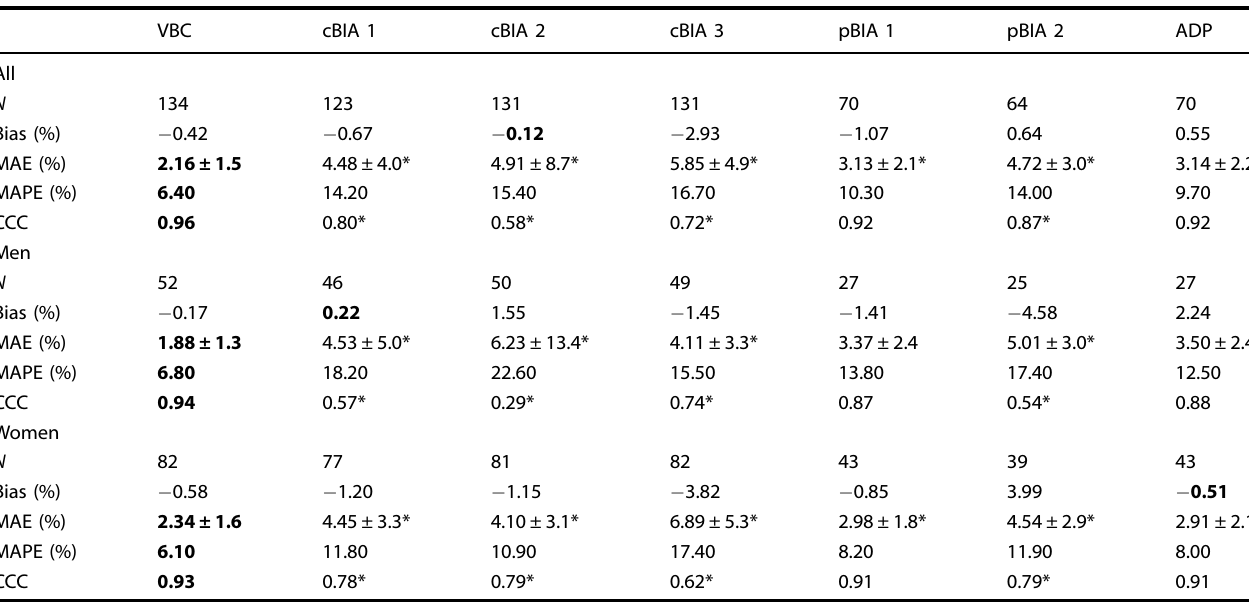
Table 2. Comparison of %BF estimates to DXA references strati fi ed by sex.